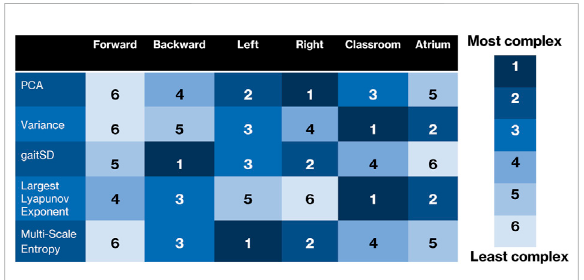
FIGURE 9 Overview of how each complexity measure ranks the six activities.Whiletherearesomesimilarities,itcanbeseenthateach measure is sensitive to different characteristics of the complexity of the data, and that many of the results are surprising or